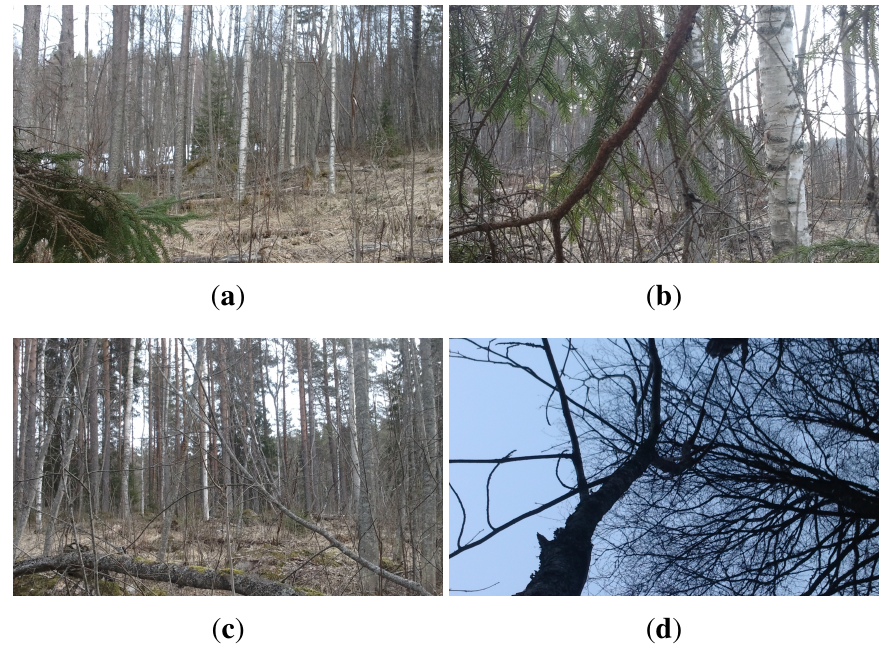
Figure 2. Examples of photos from one of the sample plots: ( a ) north facing; ( b ) south facing; ( c ) east facing; ( d ) sky facing.